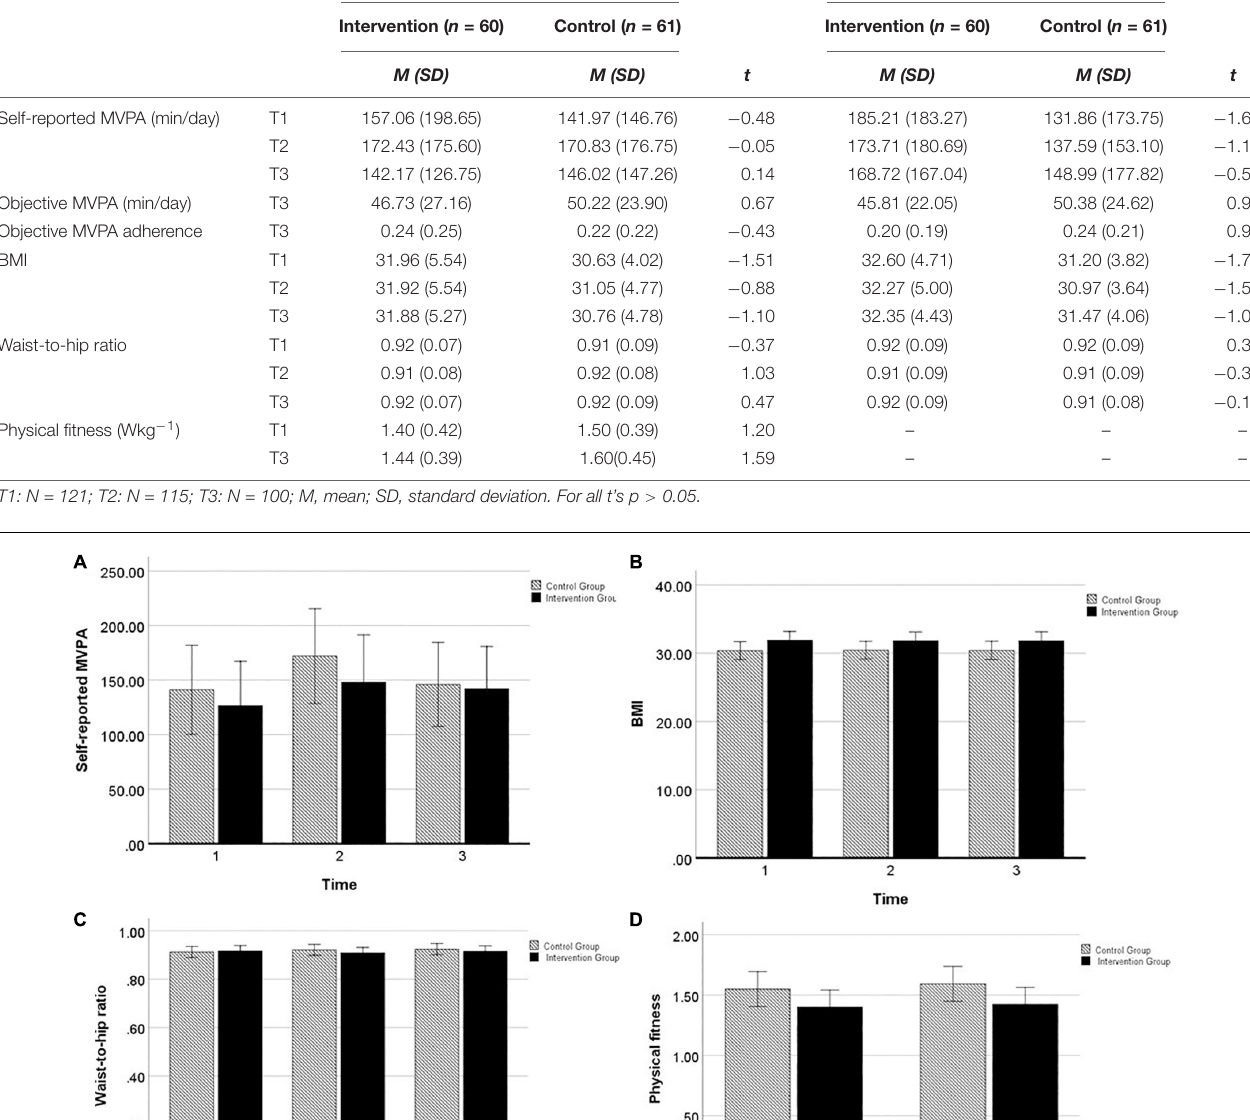
significant effect of group [ F (1,98) = 0.36, p = 0.553, η 2 time [ F (2,196) = 1.61, p = 0.202, η 2